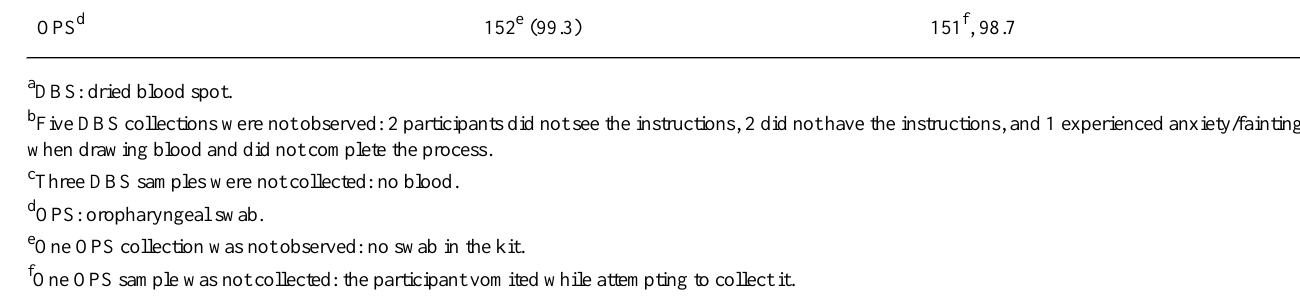
Total samples collected, n (%)Total attempted collections observed, n